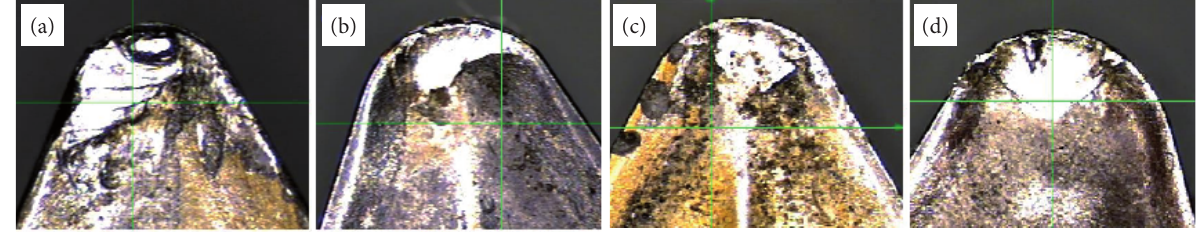
Figure 4. Wear on the inserts at the feed rate ( f ) of 0.20 mm/rev; (a) medium temperature chemical vapor deposition (MT-CVD)/ r radius: 0.4 mm, (b) physical vapor deposition (PVD)/radius: 0.4 mm, (c) MT-CVD/radius: 0.8 mm, and (d) PVD/radius: 0.8